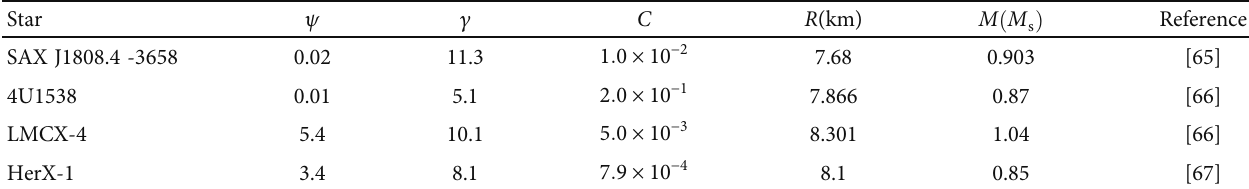
Table 1: Relativistic stellar masses and radii consistent with